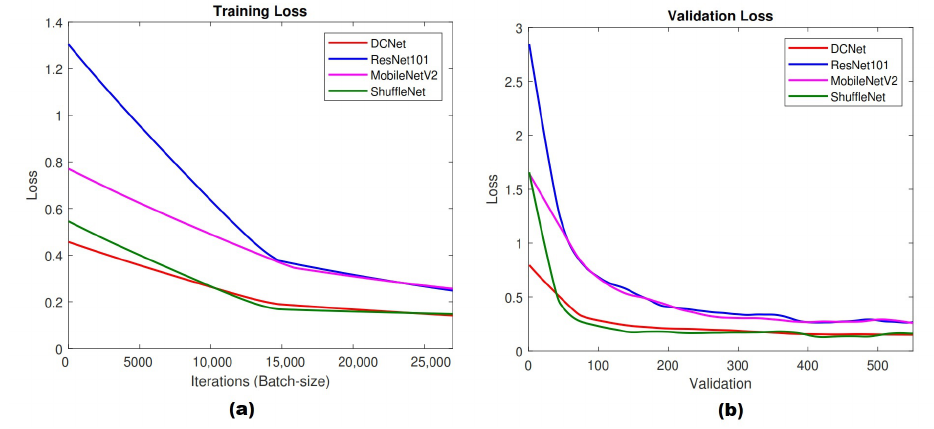
Figure 7. Training performance: ( a ) training loss, ( b ) validation